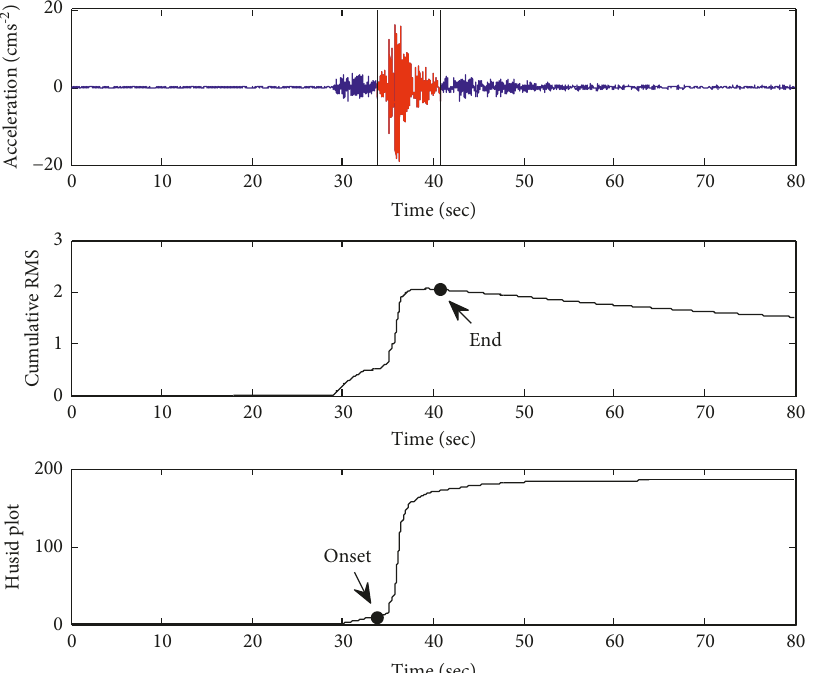
Figure 4: The detection of the S-wave of the NS component at 051YBT in Changning mainshock.